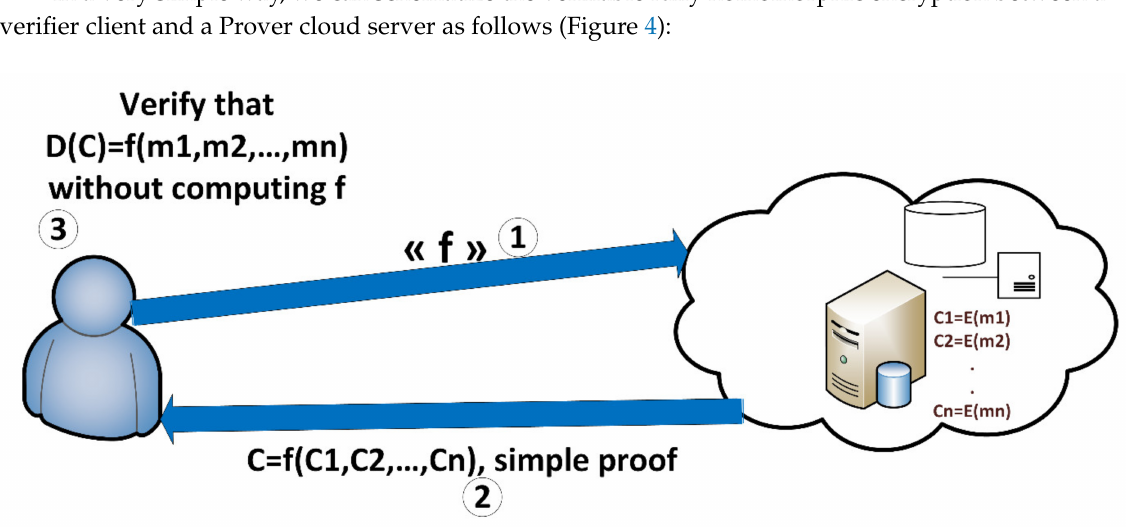
Figure 4. Verification of computation performed on encrypted data with a